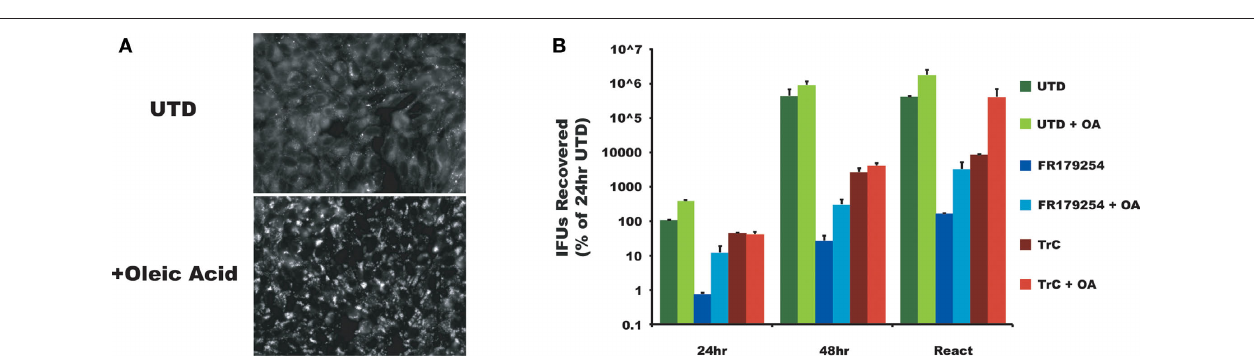
infection. One set of samples were reactivated (React) by treating with indicated drugs for 24 h, washing three times, and then culturing in the presence or absence of excess oleic acid in fresh medium lacking drugs. Reactivated samples were collected after 24 h (48 h total culture time). All data were normalized to chlamydial growth in untreated cells at 24 h post-infection (arbitrarily